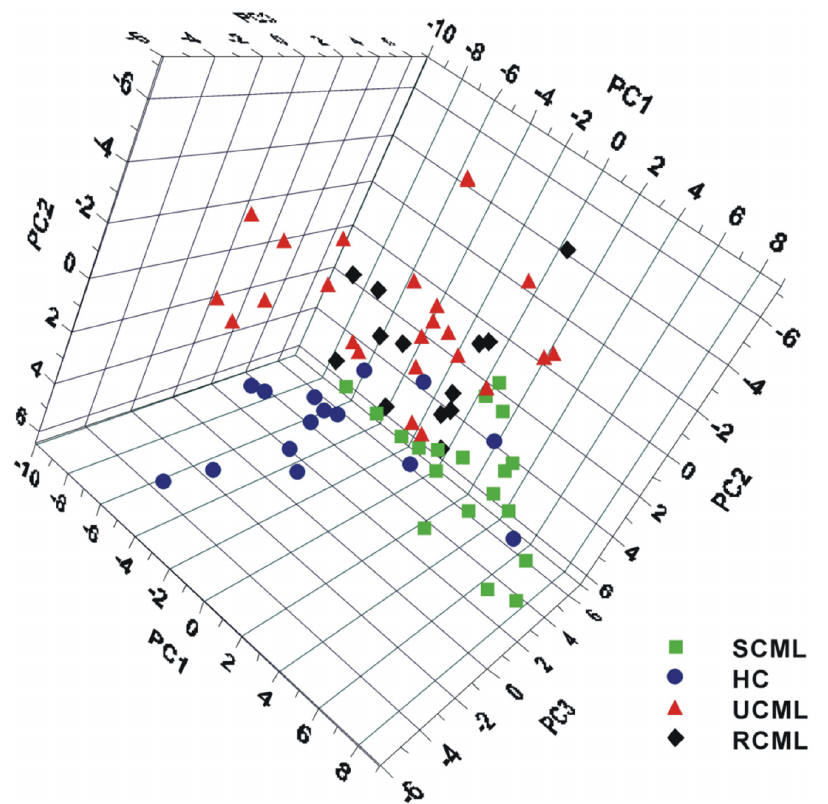
Figure 2. The scores plot of PLS-DA model (3 principal components) of the four groups. UCML, SCML, RCML and the healthy control (HC). This figure shows the difference between UCML and the healthy control and SCML and UCML, respectively. The overlapping of UCML and RCML suggested similar metabolic phenotype and indicated the therapeutic ineffectiveness of imatinib on RCML. The overlapping of SCML and HC suggested similar metabolic phenotype and the therapeutic effectiveness of imatinib on SCML.